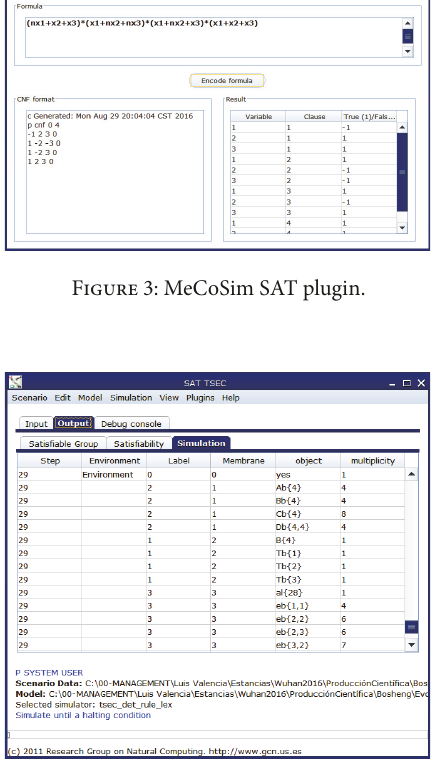
Figure 4: MeCoSim output for P systems